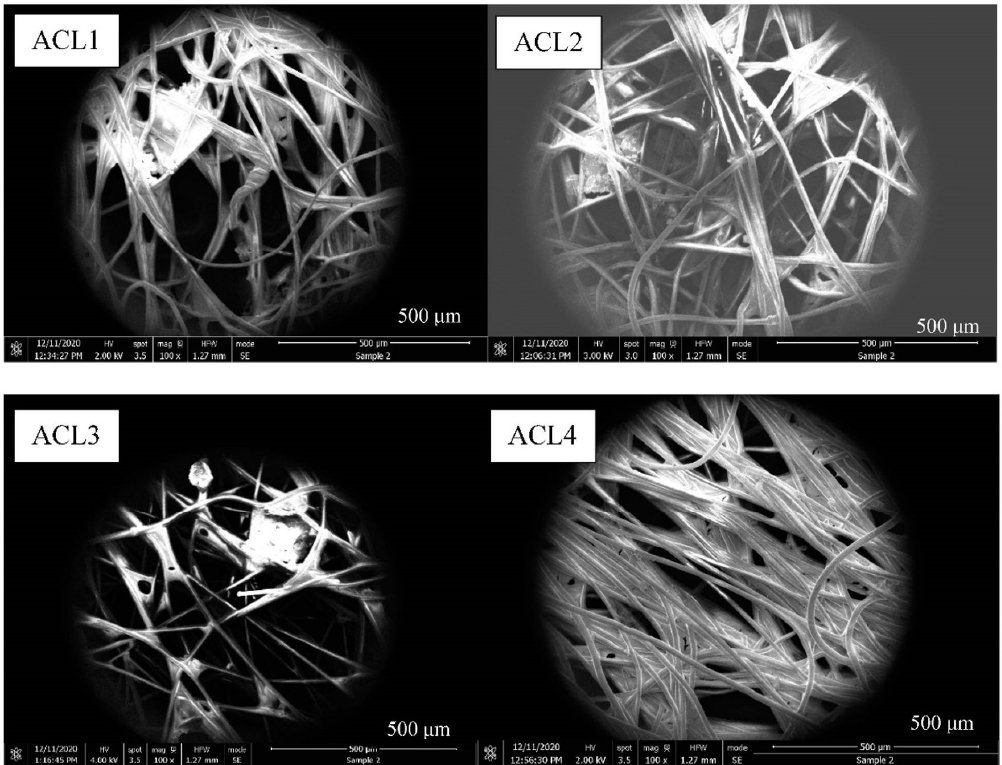
Figure 5. SEM images of ACL at 100× magnification.